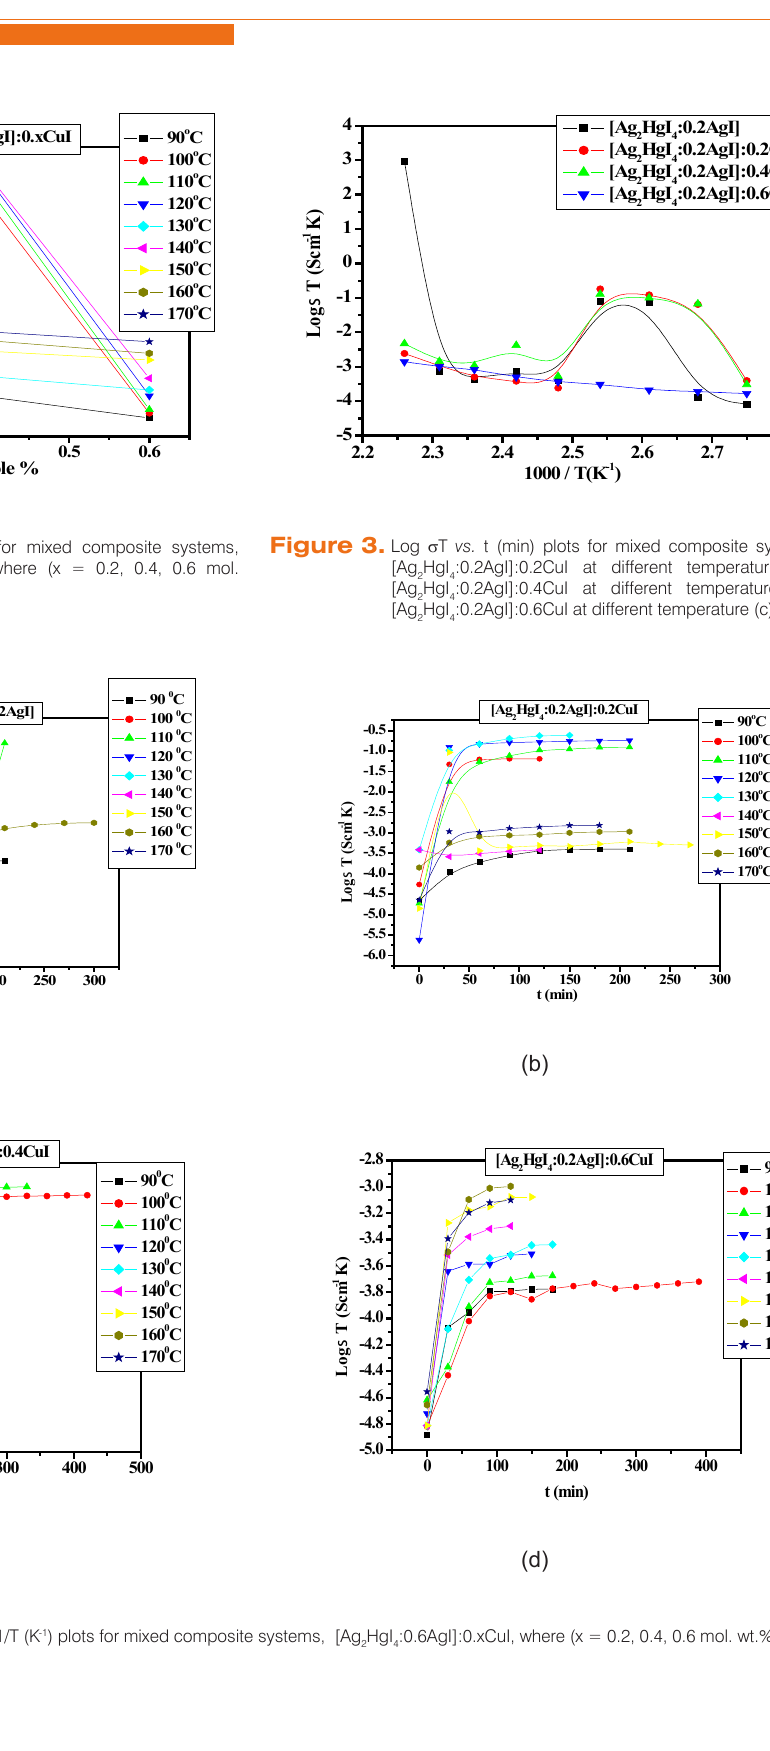
HgI :0.6AgI]:0.xCuI, where (x = 0.2, 0.4, 0.6 mol. wt.%). 2 4